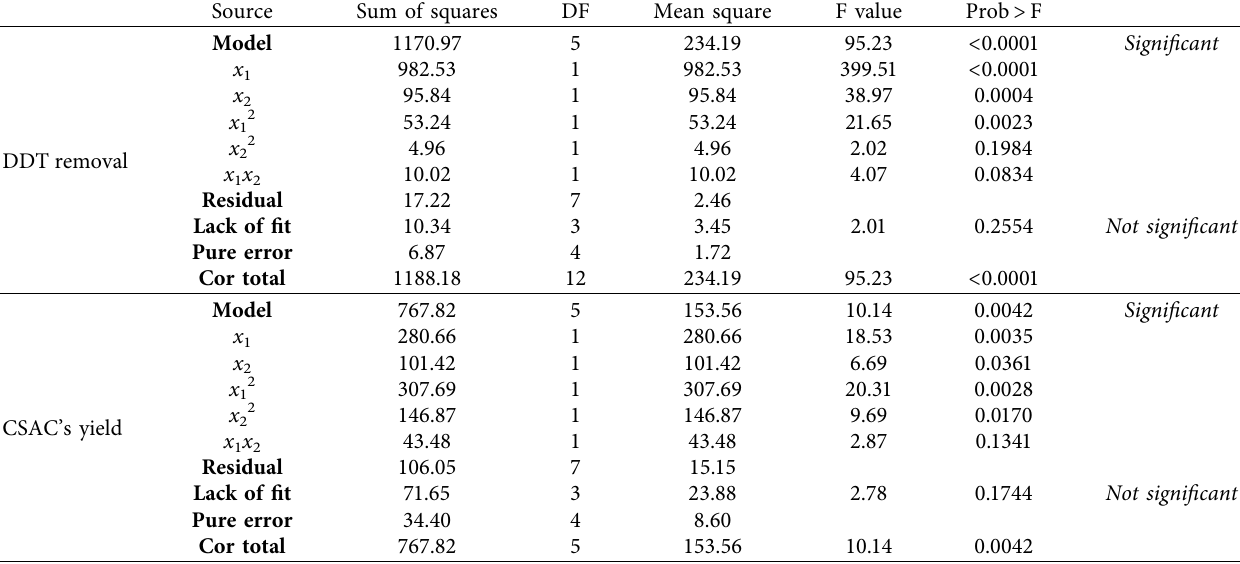
Table 4: ANOVA result for DDT removal and CSAC’s